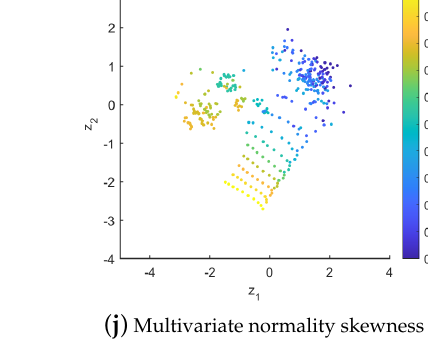
Figure 5. Distribution of selected meta–features on the projected instance